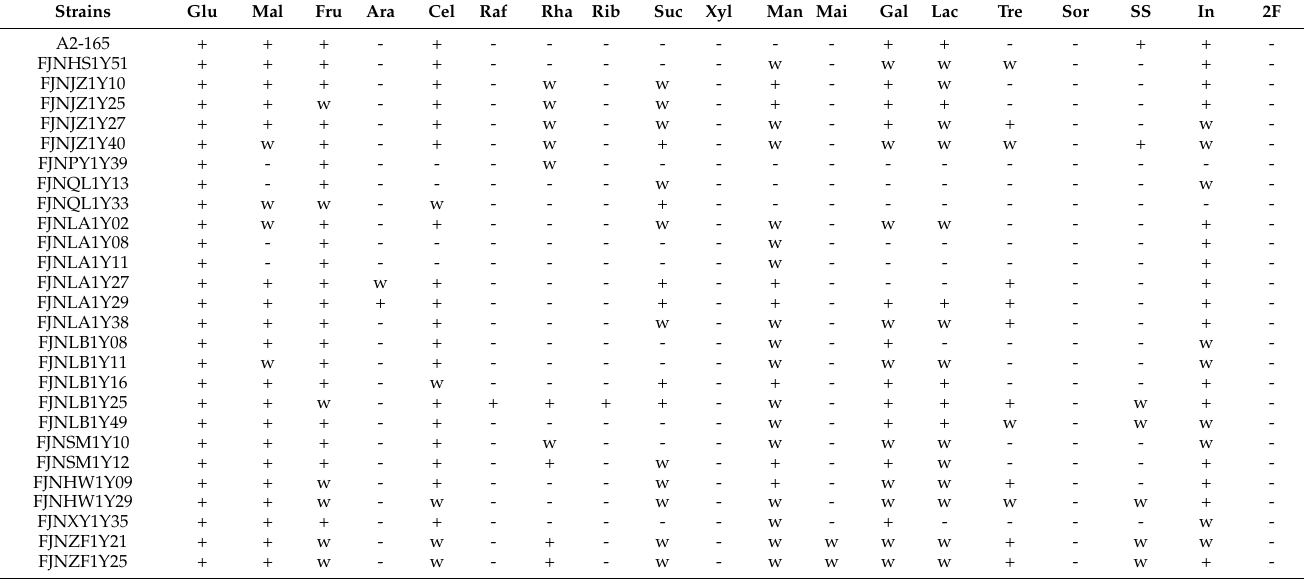
Table 3. Carbohydrate utilization of Faecalibacterium prausnitzii